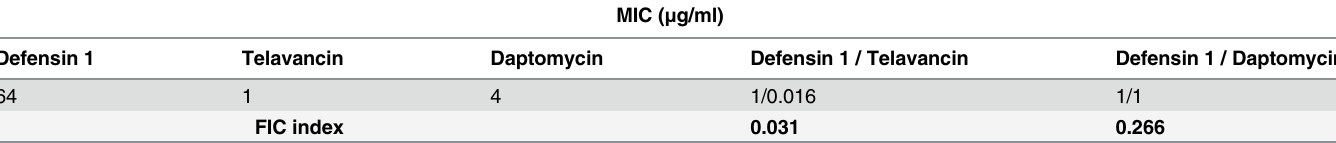
Table 2. MIC data for defensin 1, telavancin and daptomycin alone and in combination against MRSA strain